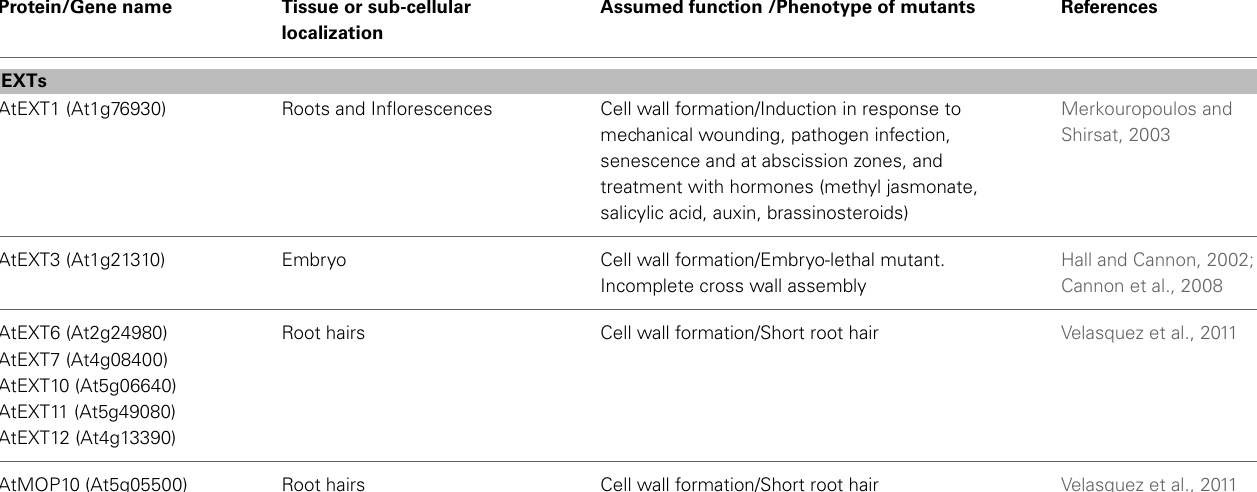
Table 1 | Examples of EXTs and EXT-related proteins characterized in the last